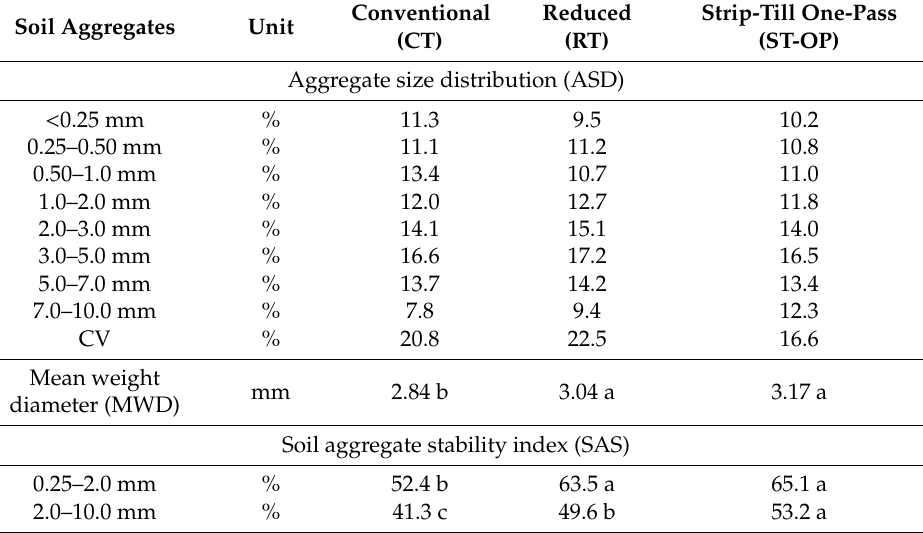
Table 3. The aggregate size distribution (ASD), mean weight diameter (MWD), and soil aggregate stability index (SAS) values, as a result of different tillage systems. Conventional (CT), reduced (RT), and strip-till one-pass (ST-OP).